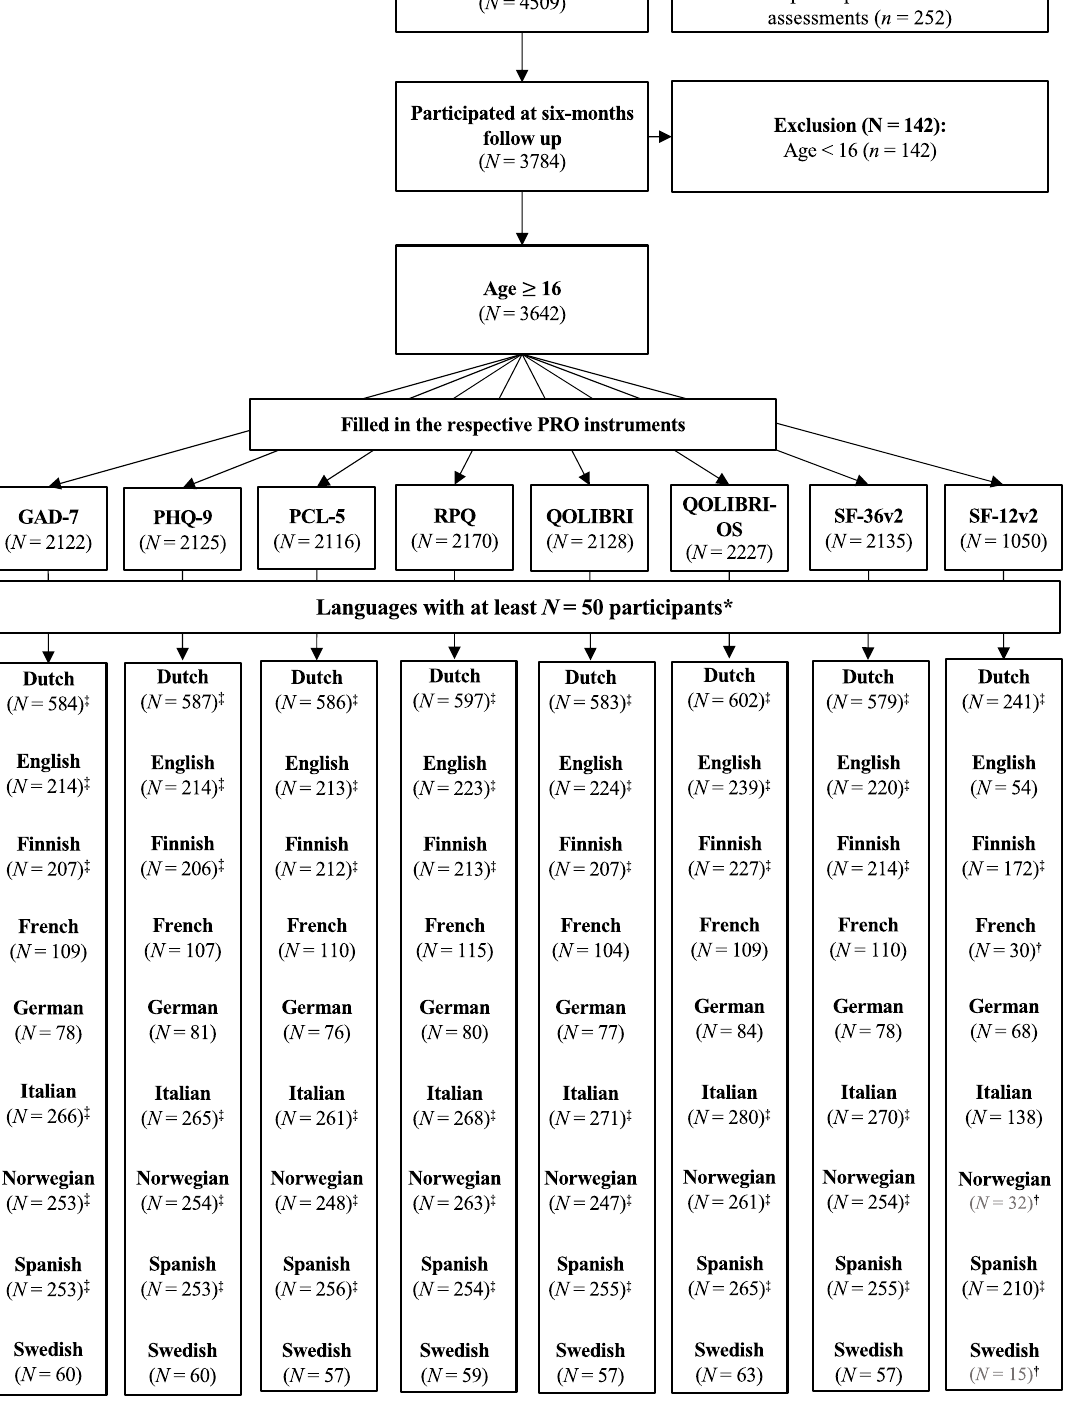
Figure 2. Number of participants for each PROM and language.